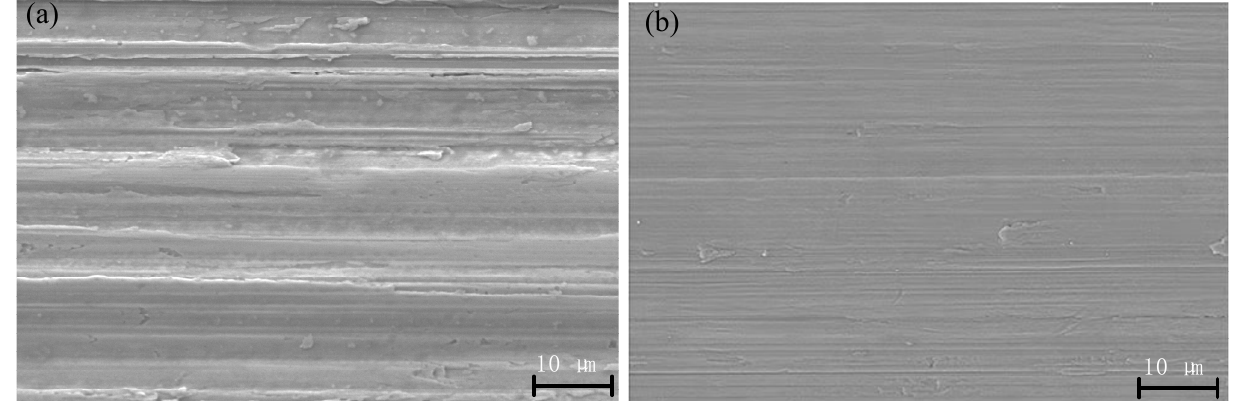
Figure 7. Typical SEM micrographs of the gear tooth surface: ( a ) C-FGG and ( b ) TUVA-FGG.